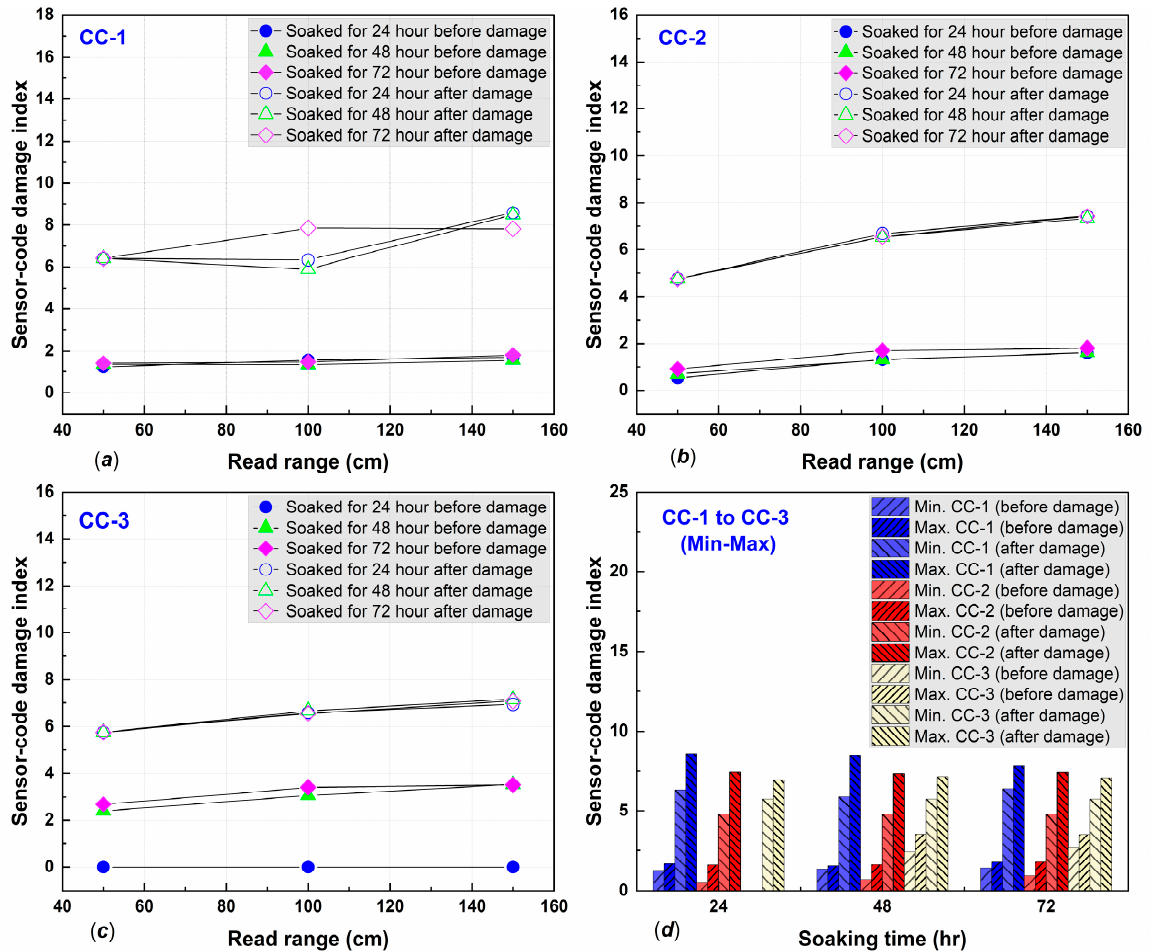
Figure 8. Damage indices of ( a ) CC-1, ( b ) CC-2, ( c ) CC-3, and ( d ) minimum and maximum of before–after damage.